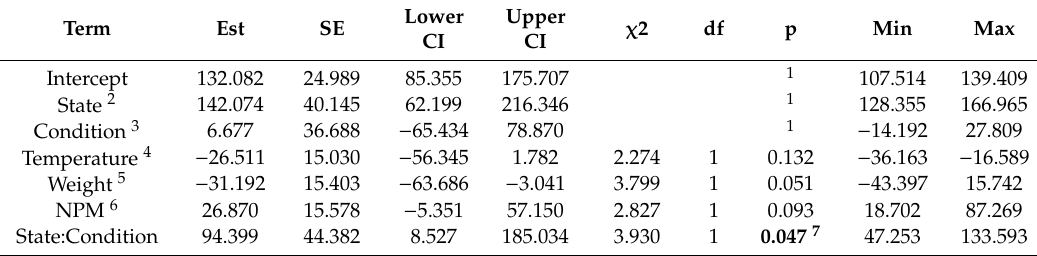
Figure 1. Mean HR ( A ) and RMSSD ( B ) of dogs during inactive wakefulness and resting in the alone and pack conditions. Boxes encompass the interval between the 25th and 75th percentiles, the horizontal line represents the median, and whiskers give the 5 and 95 percentiles. Table 3. Results of the RMSSD model (estimates, standard errors, and confidence intervals (CIs)), results of the likelihood ratio tests ( χ 2, df, and p), and the estimates obtained for model stability (min and